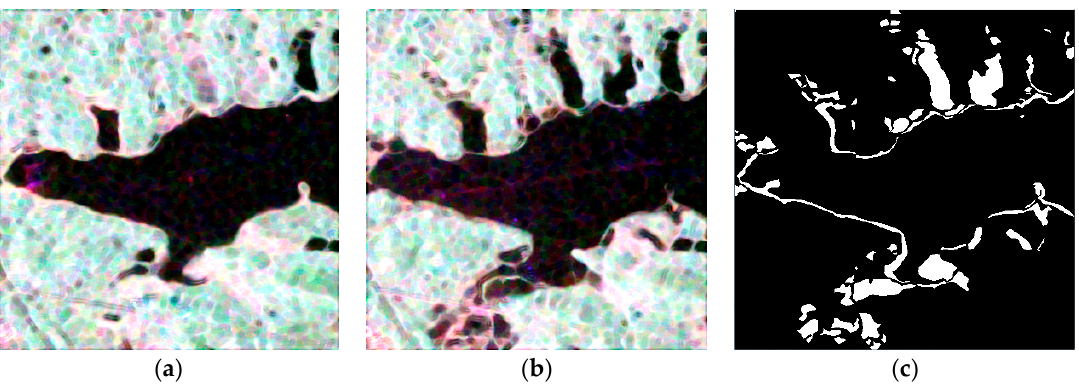
Figure 5. The Pauli-RGB images of YanDong Lake after preprocessing on ( a ) 25 June 2015; and ( b ) 6 July 2016. ( c ) Ground reference.